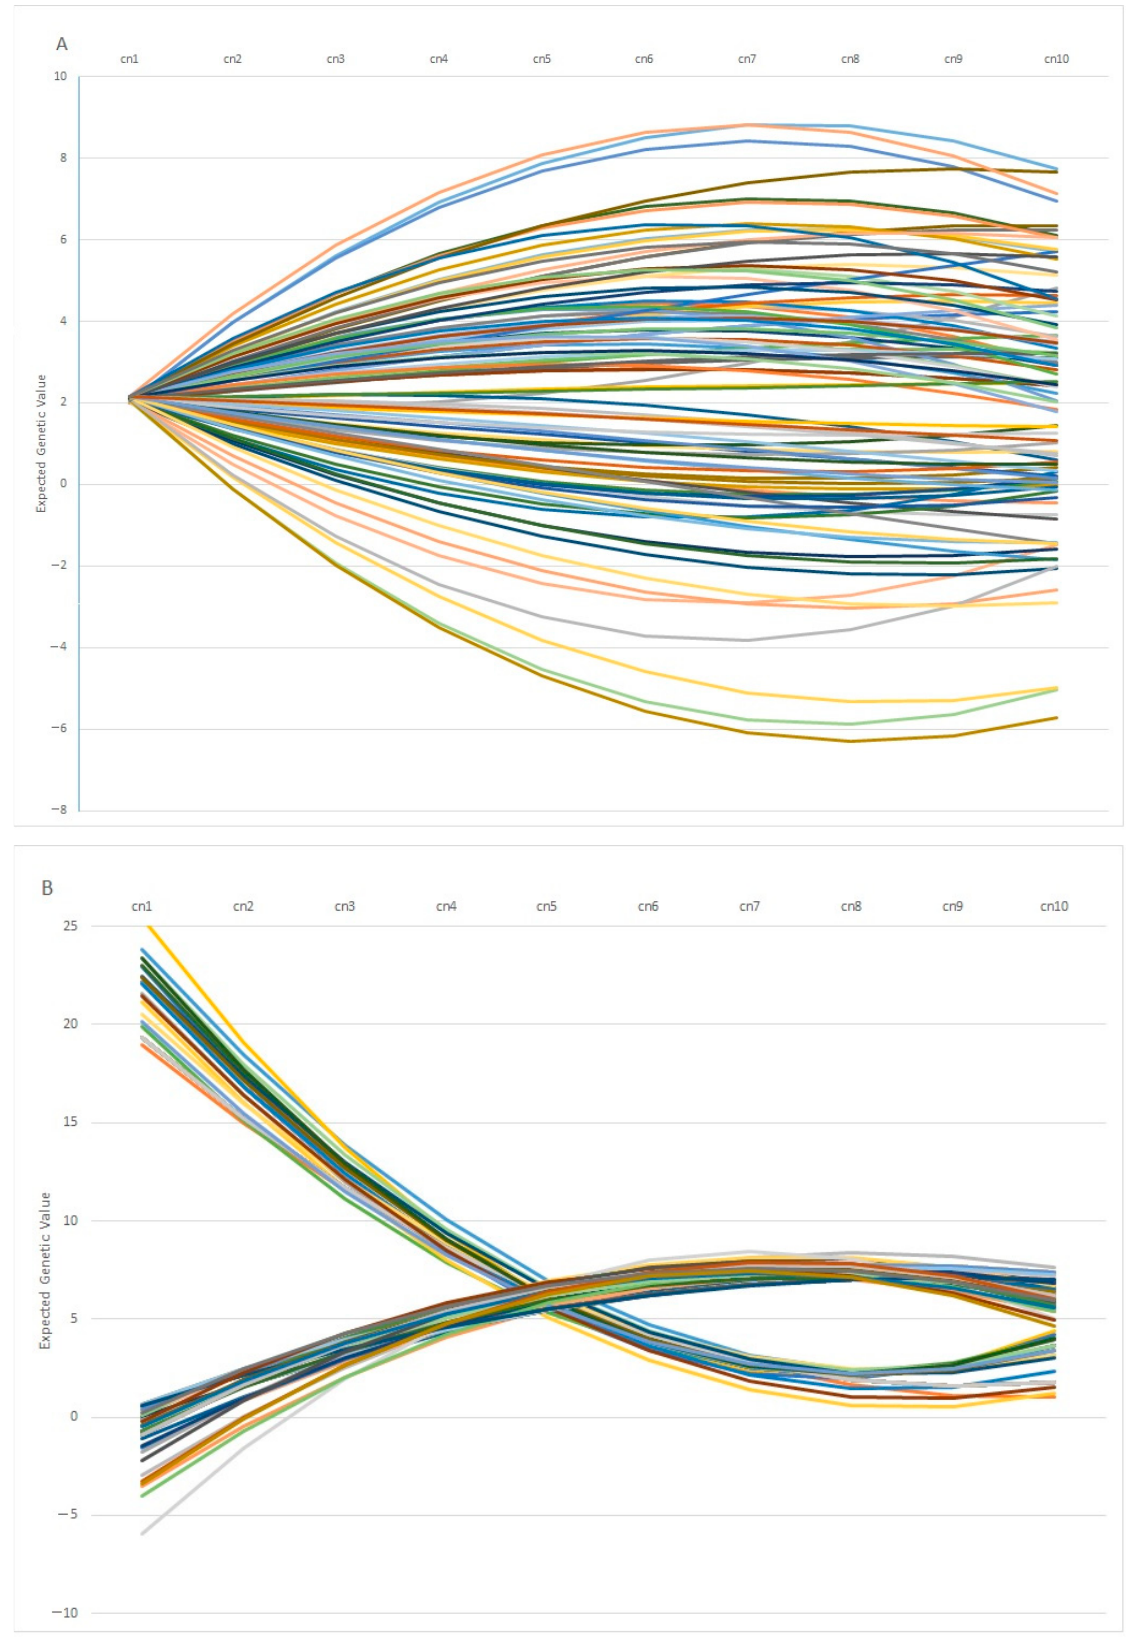
Figure 7. Variation on the Expected Genetic Values (EGV) across calvings (cn) in 100 individuals with similar EGV at 1st ( A ) or 5th calving ( B ). In our case, this parameter, defined as the difference between the genetic values ob- tained in the same character in the 1 st and 9 th calving, showed wide variability over the whole population. In addition, we determined an asymmetrical distribution with an in- creased proportion of negative values, which suggests increased reproductive efficiency at the first calving. We hypothesize that this deviation could be caused by the increased environmental variability affecting the Re values at the first calving caused by the age of the cow, since the age at first calving is influenced not only by the age at puberty but also by when each breeder decides to include the heifer in the mating lot. This breeder’s influ- ence is reduced when the calving number increases (in addition to reducing the variability of the parameter with the elimination of less fertile animals). 3.5. Genome-Wide Association Study (GWAS) and Functional Analysis Genome-wide association analyses detected 5 SNPs significantly associated with re- productive efficiency (p-value < 10 − 4 , Table 7), located in 2 genomic regions on chromo- somes BTA4 and BTA28 (Figure 8). The estimated average effect of the significant SNPs in absolute values was 4.91. The in-silico functional analysis revealed the presence of 5 candidate genes ( NRF1, SSMEM1, CPA5, RYR2, and ZP4 ) previously linked with known biological processes, molecular functions, and pathways related to fertility located within ± 500 Kb of the significant SNPs (Table 7), among which there were processes related to steroidogenesis, embryonic development, and spermatogenesis in cattle, goat, rabbit, mouse, and human models.